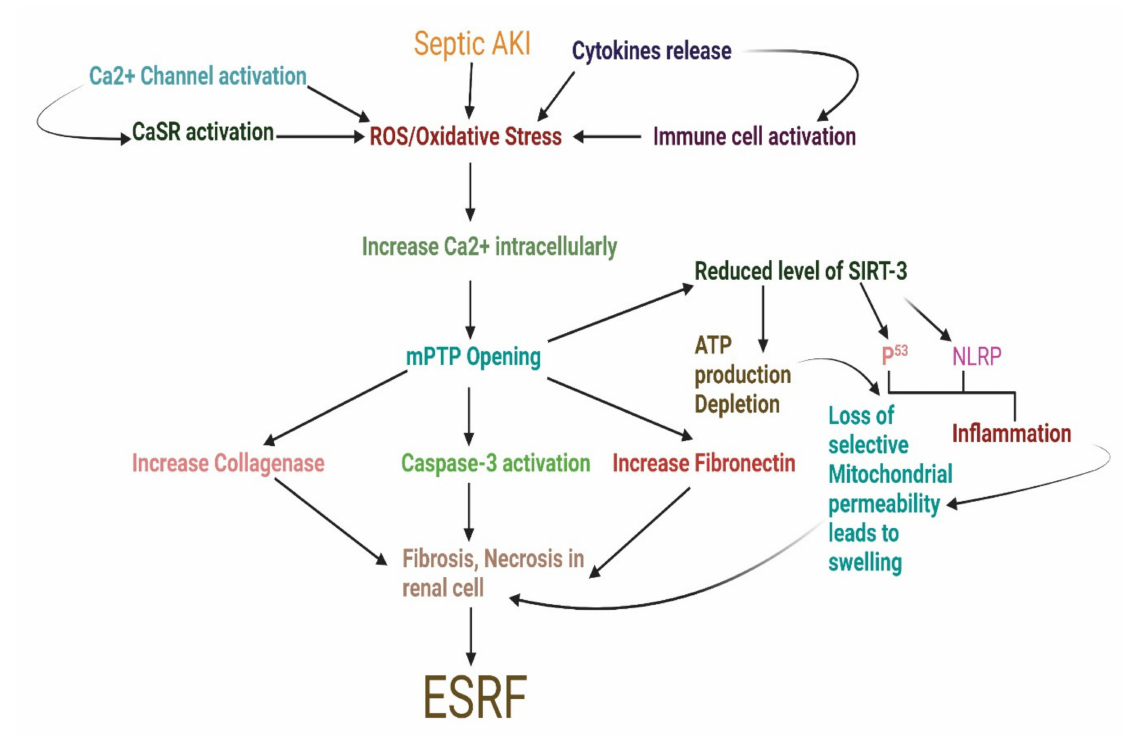
Figure 2. Schematic diagram exploring sepsis-associated acute kidney injury progression through enhanced biomolecules burden to End-stage renal failure. AKI, acute kidney injury; ATP, adenosine triphosphate; CaSR, calcium-sensing receptor; ESRF, end-stage renal failure; mPTP, mitochondrial permeability transition pore; NLRP, NACHT, LRR, and PYD domains-containing protein; ROS, reactive oxygen species; SIRT3, sirtuin